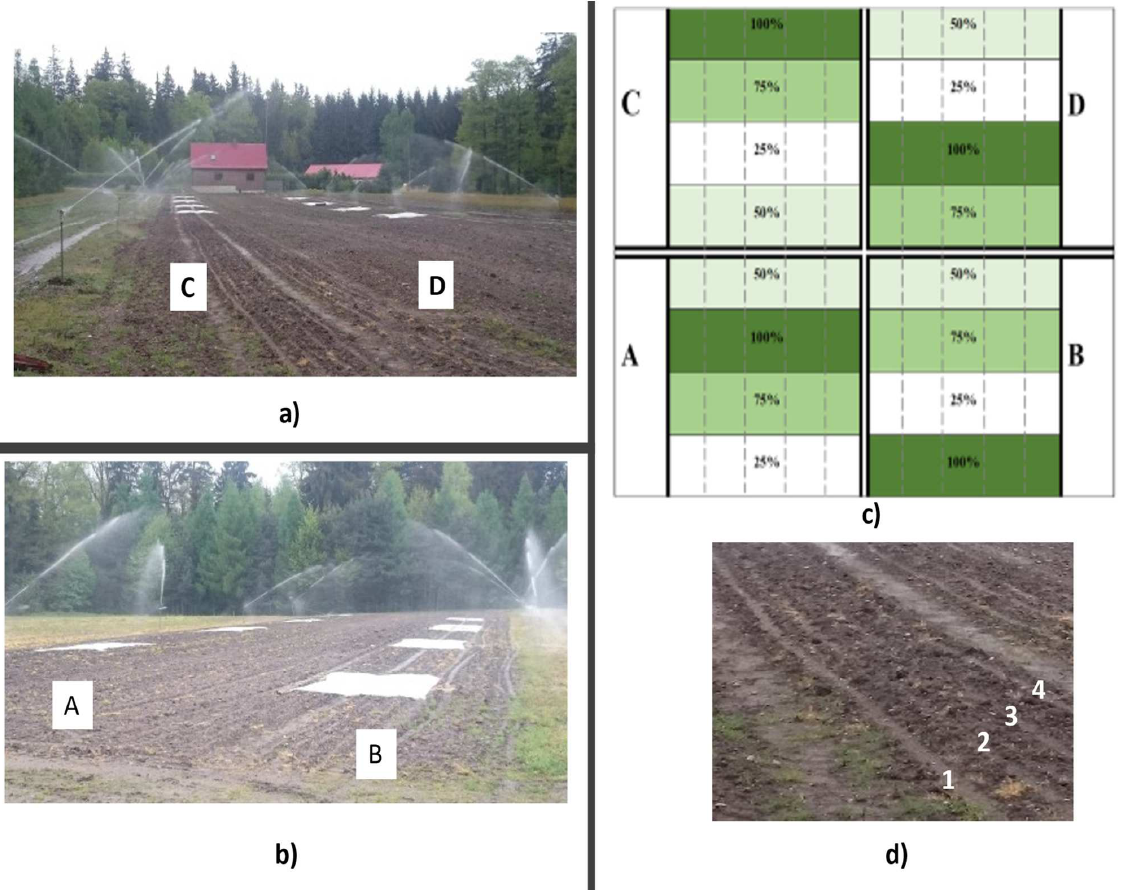
Figure 4. The experimental set-up divided into variants of the experiment in Muchów Forest Nursery; ( a ) Block C and D and working sprinklers, ( b ) block A and B and working sprinklers, ( c ) experiment design; letters stand for block names; 100%-full rate (control), 75% of the rate, 50% of the rate and 25% of the rate; the dashed line marks the rows where the oak was planted; the desired variant of the experiment is marked with a separate color, ( d ) rows in which acorns were planted; the numbers (1–4) are rows.